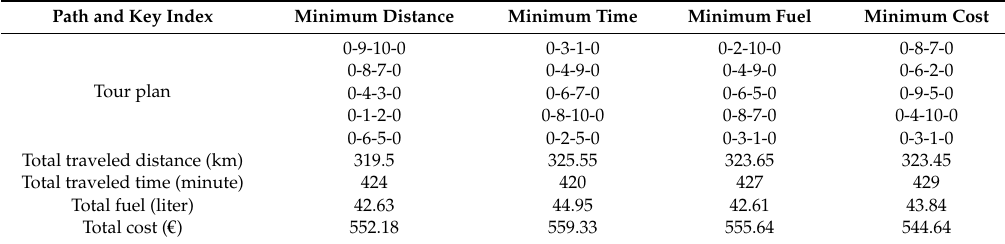
Table 3. Comparisons of scenarios of 11 nodes with di ff erent objective